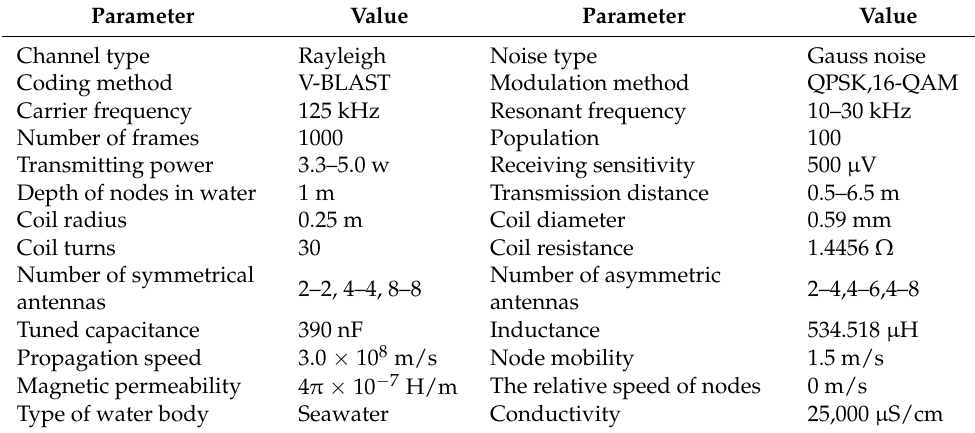
Table 2. The main e × perimental parameters.